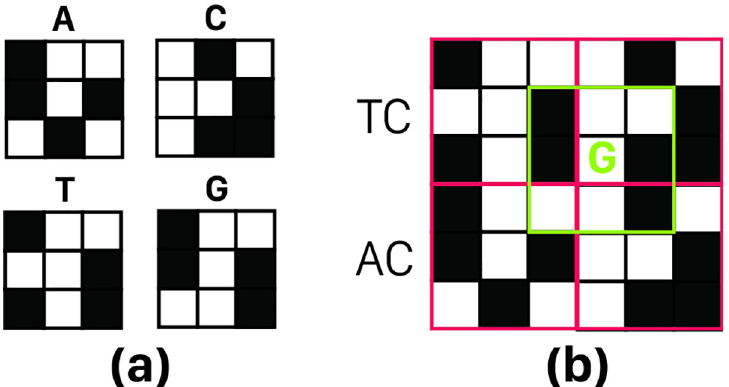
Fig 6. (a) Set of four codes with N = 4, d = 3. (b) a c-grid (2 × 2 grid) with an overlap noise of length four, so if E = 1 will be chosen. This coding set is unacceptable (because size of peak in this example is 4 too and 4—E (= 1) is the maximum acceptable noise); overlap noise location is marked with a green